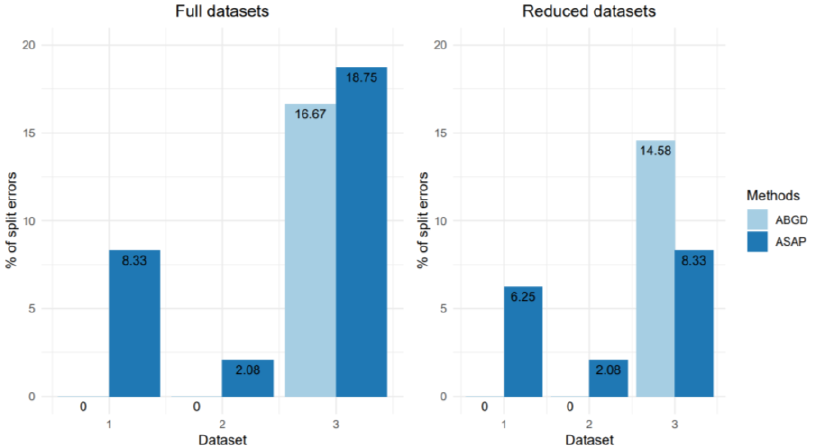
Figure 9. Mismatch rates corresponding to splits (when a putative species is split into several OTUs) observed with the three datasets processed with the ABGD and ASAP methods. The graphs represent, for the dataset in its full version or after reduced to one sequence per haplotype, the proportion of putative species that are split by the different methods. Diversity 2022 , 14 , x FOR PEER REVIEW